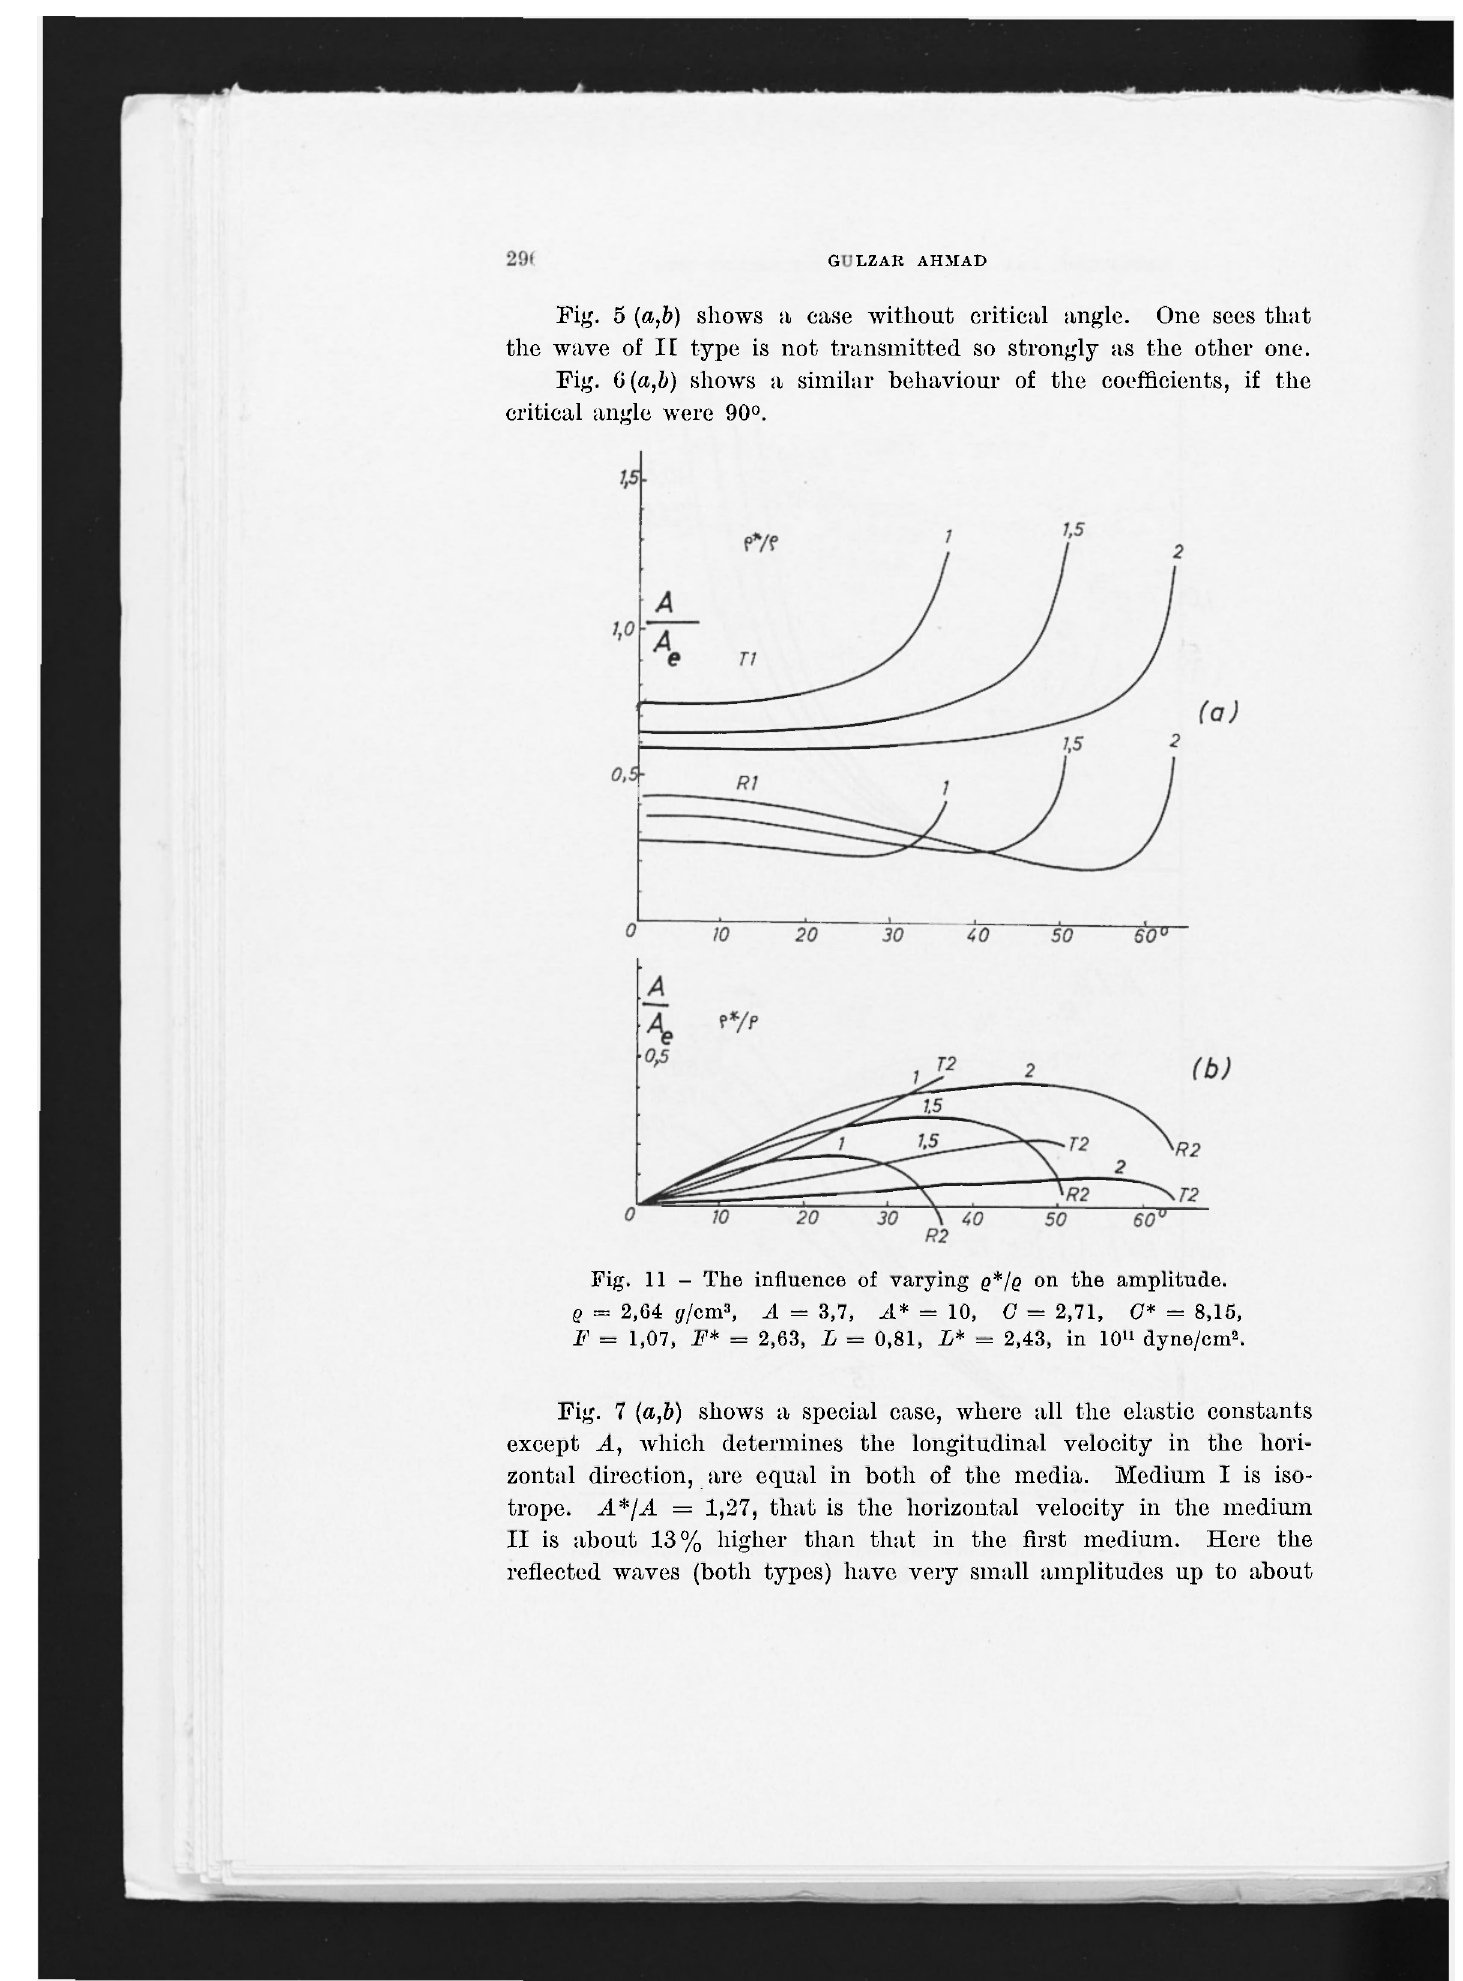
Fig. 7 (a,b) shows a special case, where all the elastic constants except A, which determines the longitudinal velocity in the hori- zontal direction, are equal in both of the media. Medium I is iso- trope. A*/A = 1,27, that is the horizontal velocity in the